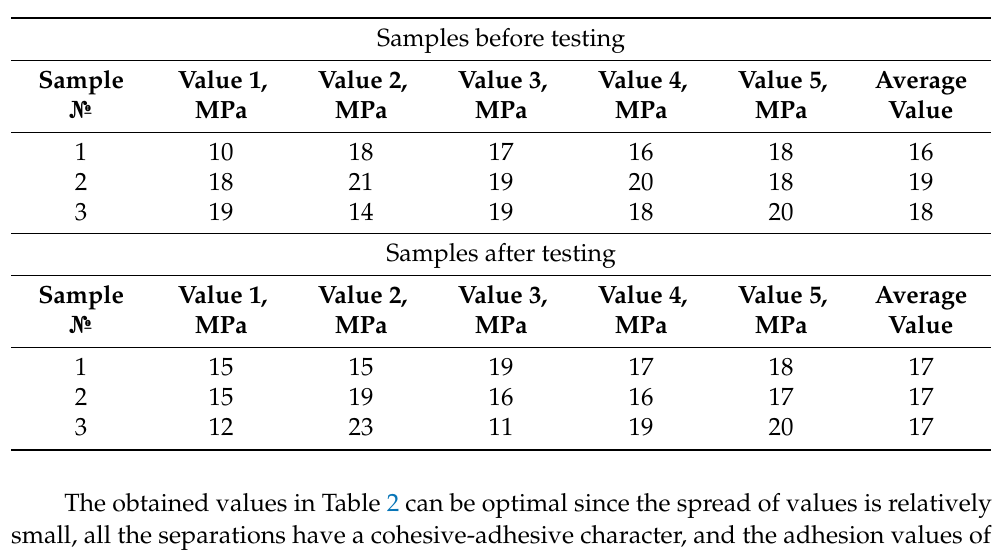
Table 2. Results of pull of test after autoclave decompression test.